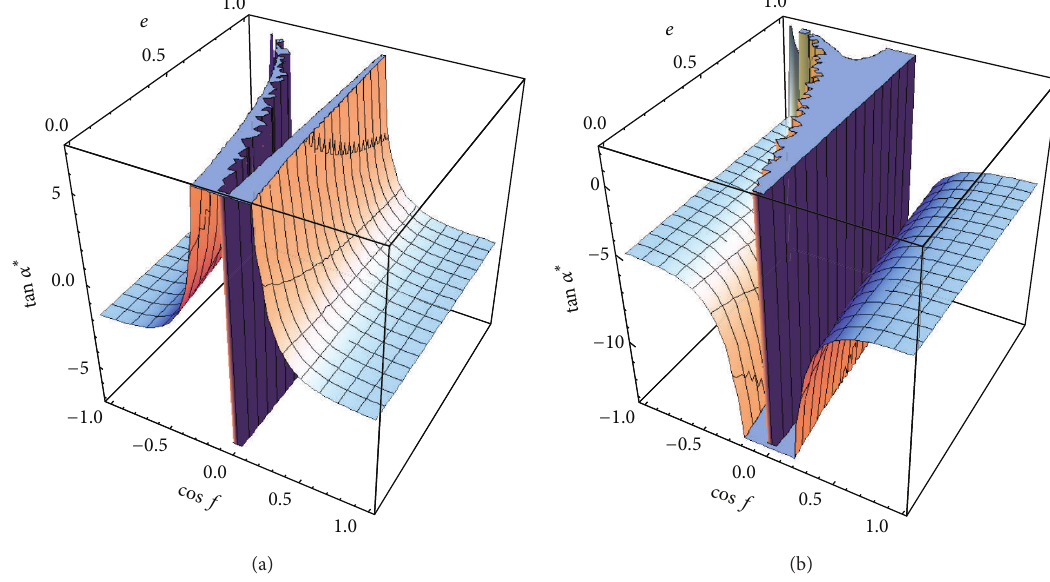
Figure 4: (a) The optimum cone angle that maximizes the rate of change of eccentricity when taking the positive sign in the numerator. (b) The optimum cone angle that maximizes the rate of change of eccentricity when taking the negative sign in the numerator.